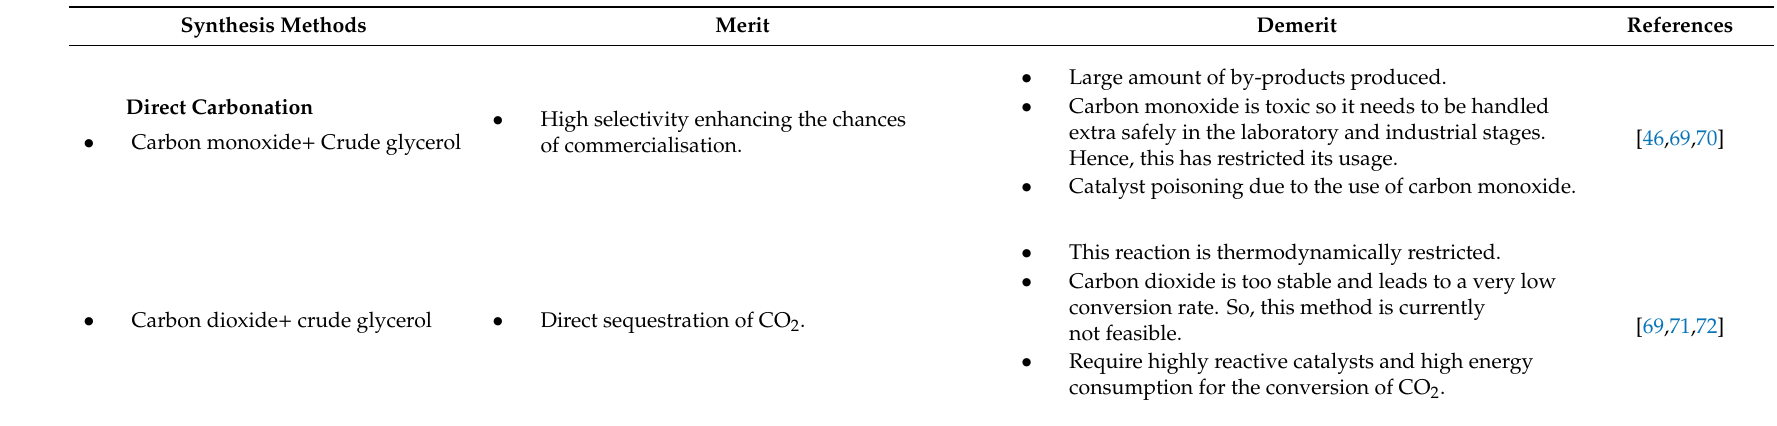
Table 5. Advantages and disadvantages of di ff erent routes of glycerol carbonate